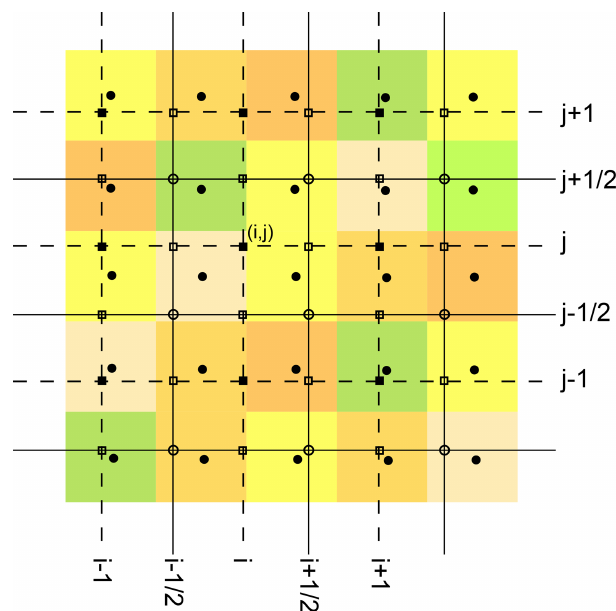
Figure 1. Computational grids. The colored pixels represent the el- evation values of the original DEM. The lines define the edges of the IMEX-SfloW2D computational cells. The elevation values at the centers (filled squares), faces (no-fill squares) and corners (no- fill circles) of the computational cells are obtained by interpolating the pixel values associated with their centers (filled